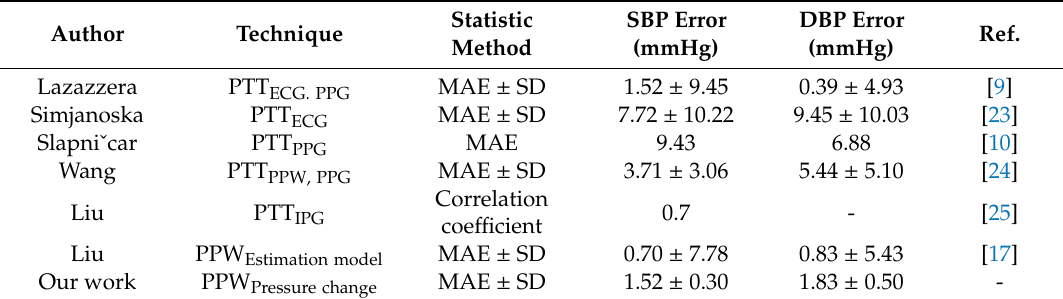
Table 2. Recent works for blood pressure